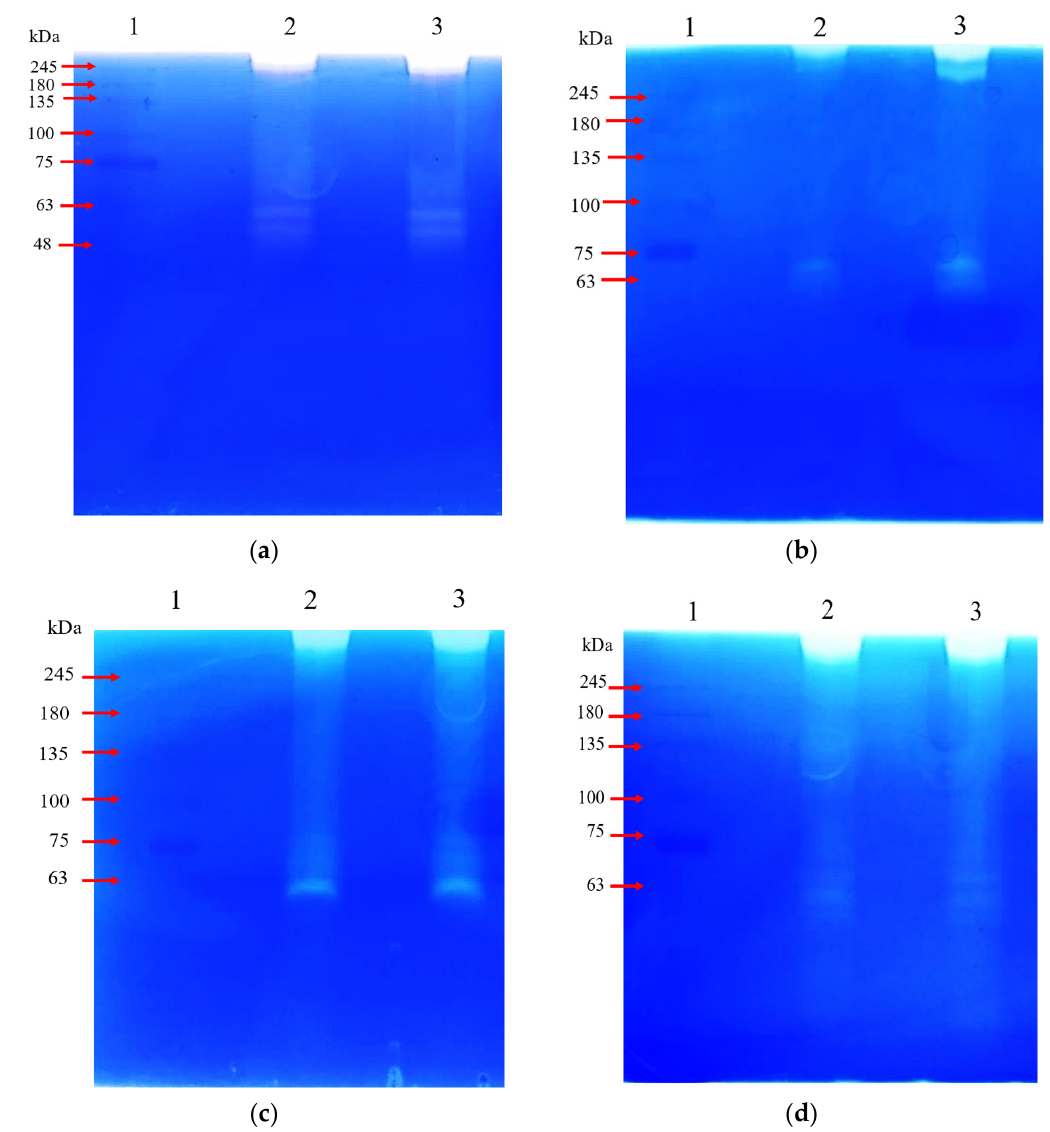
Figure 4. Zymography gels showed the transparent bands produced by the proteases found in the crude gingipains sample of P. gingivalis HG66. All Lane 1 was BLUeye pre-stained protein standards. ( a ) Crude gingipains samples without any treatment (2 and 3). ( b ) Crude gingipains sample treated with (2) and without (3) Leupeptin inhibitor. ( c ) Crude gingipains sample treated with (2) and without (3) Cathepsin B inhibitor II. ( d ) Crude gingipains sample treated with (2) and without (3) TLCK inhibitor.